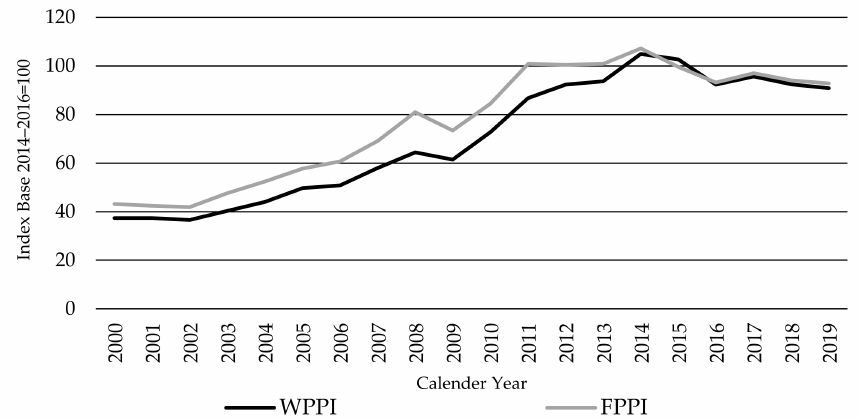
Figure 7. The Global Weaner Cattle Producer Price Index WPPI and Finished Cattle Producer Price Index FPPI, source: own